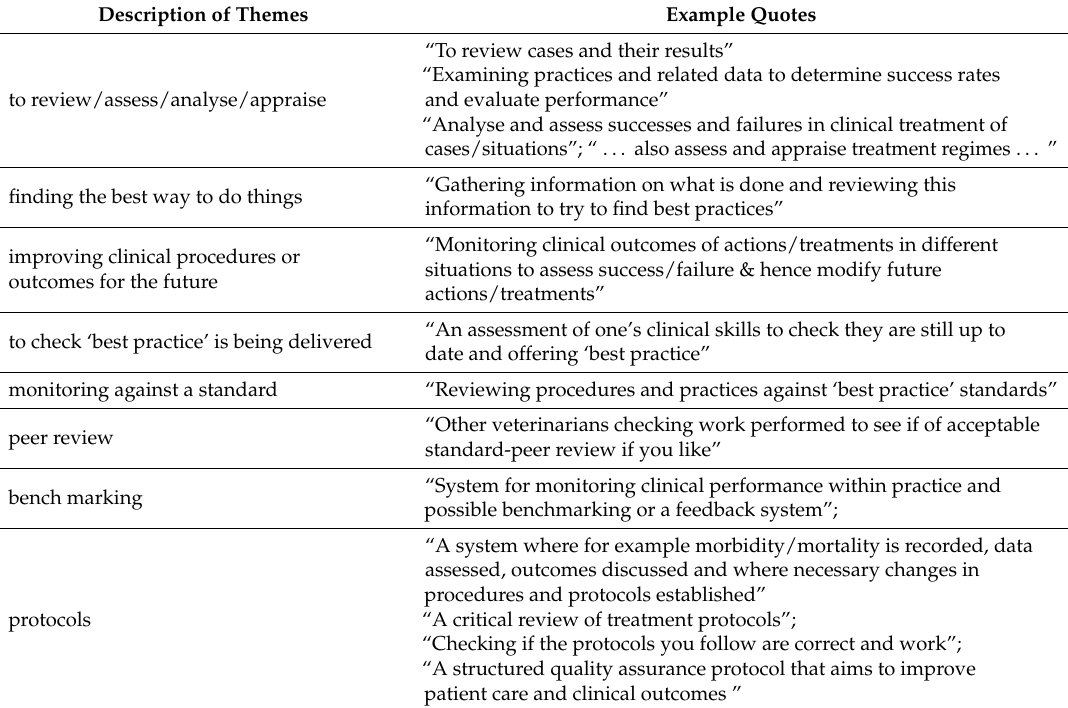
Table 1. The themes that were identified from the suggested definitions of clinical audit by questionnaire respondents in a survey investigating the experiences and attitudes of UK farm animal clinicians towards clinical audit ( n =